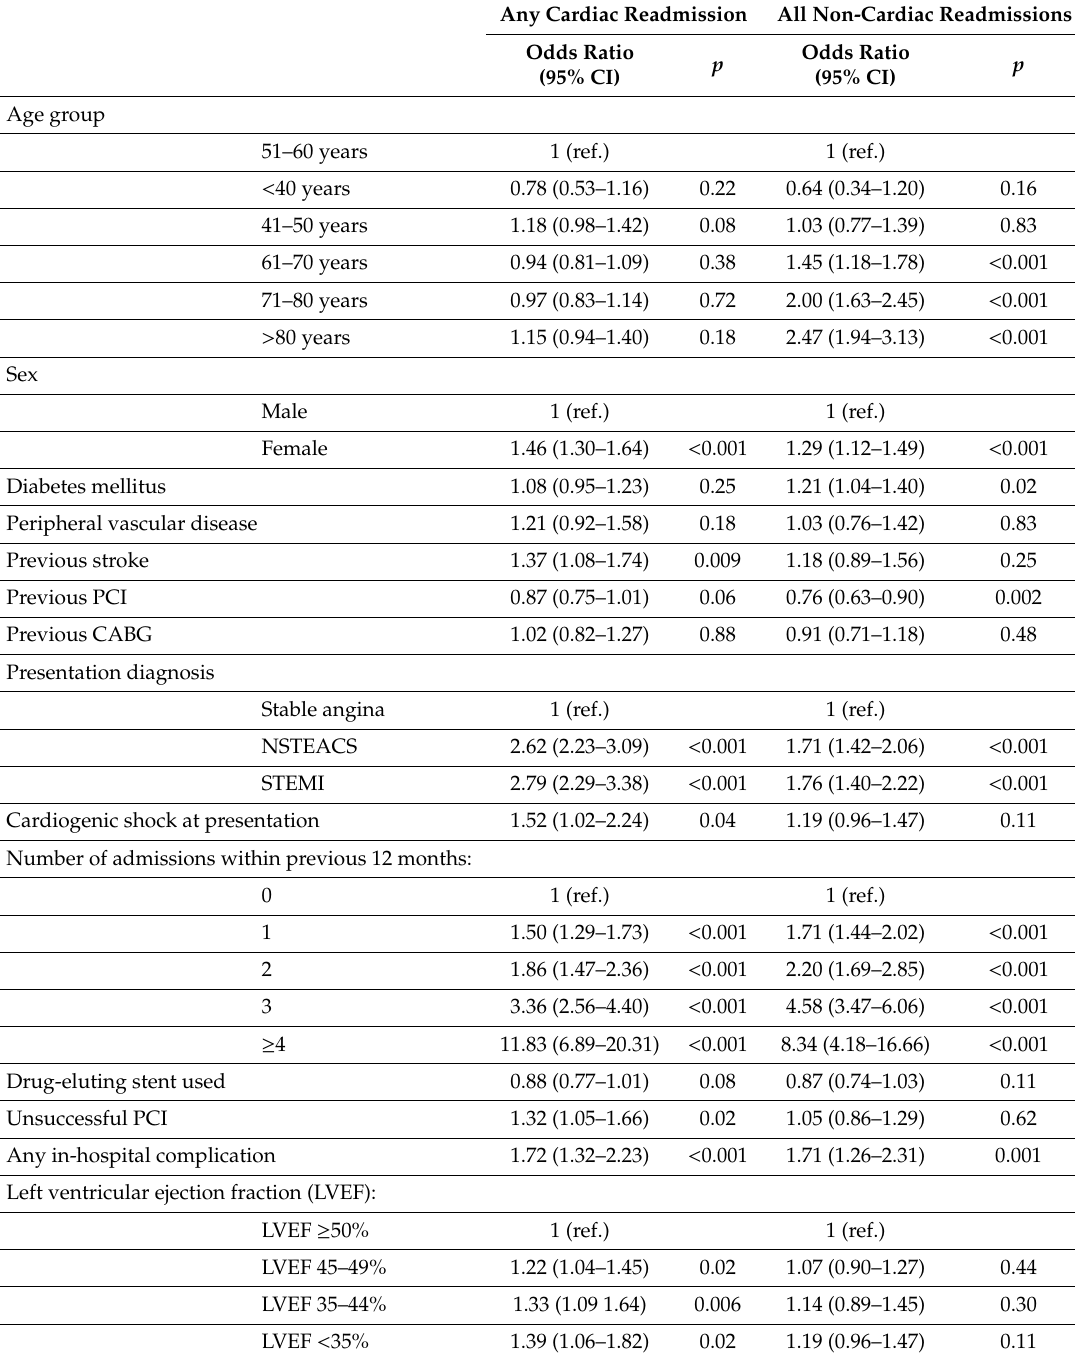
Table 3. Independent predictors of 30-day cardiac and non-cardiac readmissions